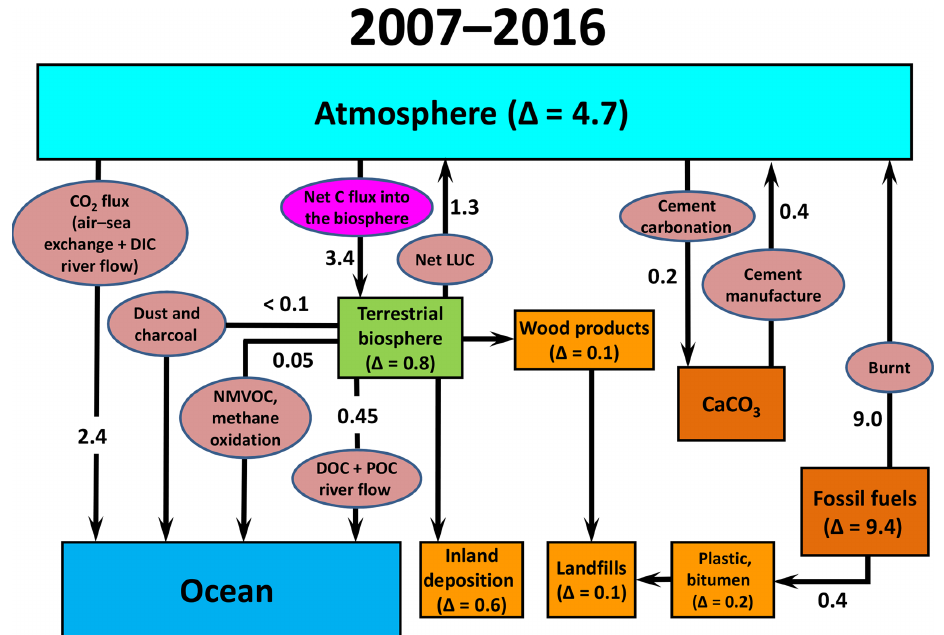
Figure 7. Expanded summary of the main components of the global carbon cycle for the 2007–2016 period. The fluxes are those given by Le Quéré et al. (2018) as shown in Fig. 1 above. These broad fluxes have then been modified based on Table 4 and the details provided in specific sections above. Rectangular boxes refer to identified important carbon storage pools in the global carbon budget. Fluxes described in ovals refer to key fluxes between these storage pools.